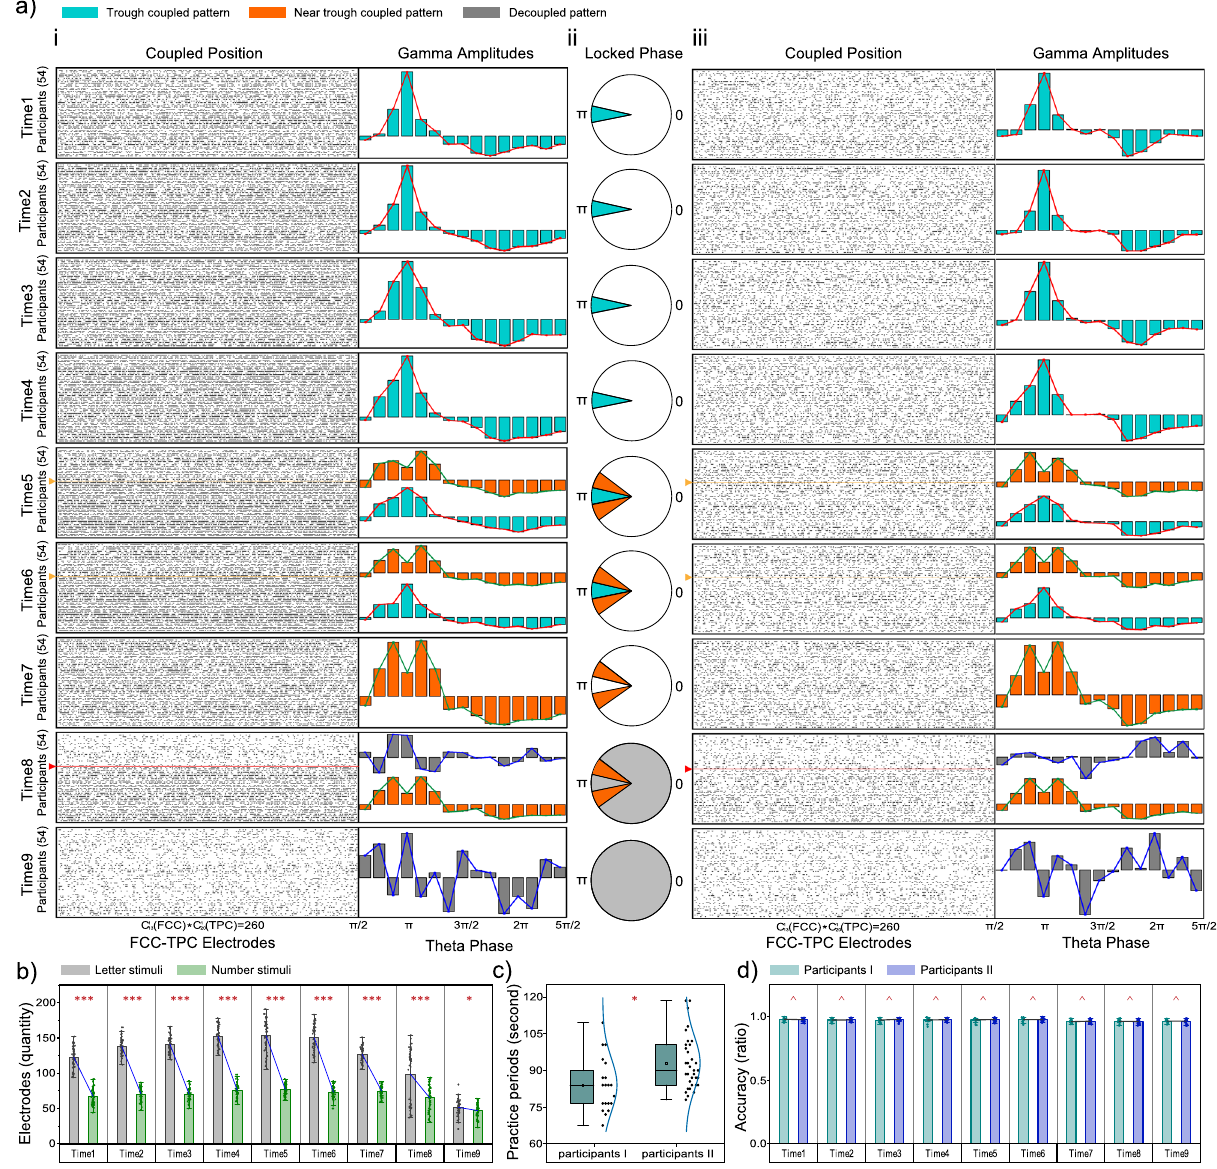
Fig. 3 Dynamics of the theta-gamma phase-amplitude coupling. n = 54, a Black dots indicated coupled positions, that theta phases of 13 electrodes in the frontal-central cortex (FCC) surface modulating gamma amplitudes of 20 electrodes in the temporal-parietal cortex (TPC) surface, for each participant, a total of 260 (13*20) electrode positions where theta-gamma phase-amplitude coupling (PAC) may occur. Cyan bars indicated that averaged gamma amplitudes in TPC surface were locked at the trough of the theta cycle in FCC surface. Orange bars indicated that averaged gamma amplitudes burst near the trough of the theta period. Grey bars showed that the coupled phase of the trough or near the trough disappeared. Polar coordinates in the ii panel of the fi gure illustrated positions of the coupled phase in a cosine function, in which π was the minimum point. From time 1 to time 9, the number of coupled electrodes gradually decreased, and the position of coupled phase gradually moved away from the theta wave trough. Yellow and red lines divided participants into the I and II group, and they have different dynamics of the theta-gamma PAC. The (i) and (iii) panel showed PAC dynamics of the heavier- load and easier-load condition in the length mental task, respectively. b PAC of the heavier-load condition (gray columns, means ± standard deviations) occurred more often than the easier-load condition (green columns, means± standard deviations), indicated by a one-way repeated ANOVA (*** p < 0.0001). c The pra c tice periods (means ± standard deviations) for the I and II group of participants was signi fi cant different, indicated by a one-way repeated ANOVA (* p < 0.05). d Behavior performance, the accuracy rate of the lengthy mental task, was not signi fi cant difference between I (cyan columns, means ± standard deviations) and II (blue columns, means ± standard deviations) group of participants, indicated by a one-way repeated ANOVA (^ p >